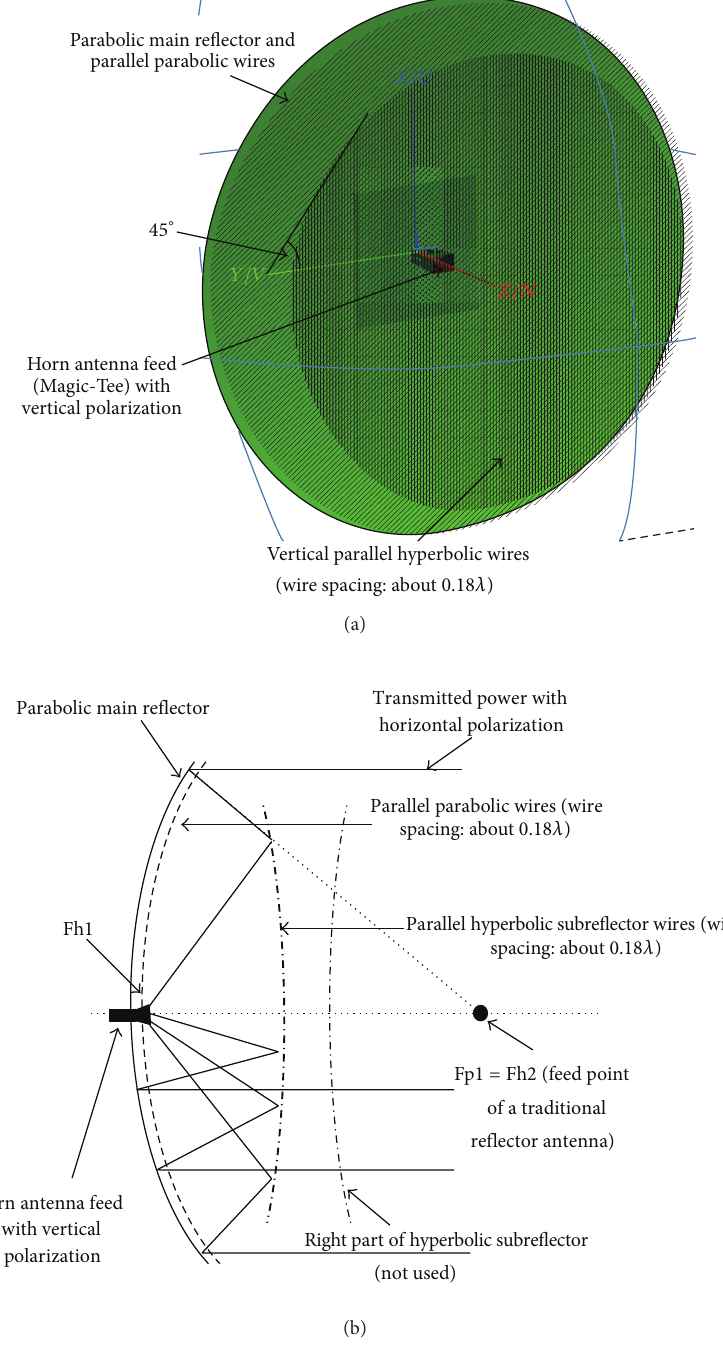
Figure 3: (a) Cassegrain antenna structure and (b) its design